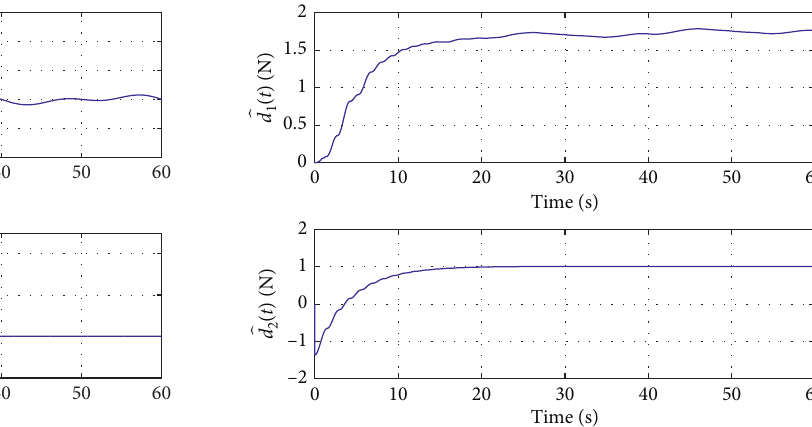
Figure 8: Estimates of d